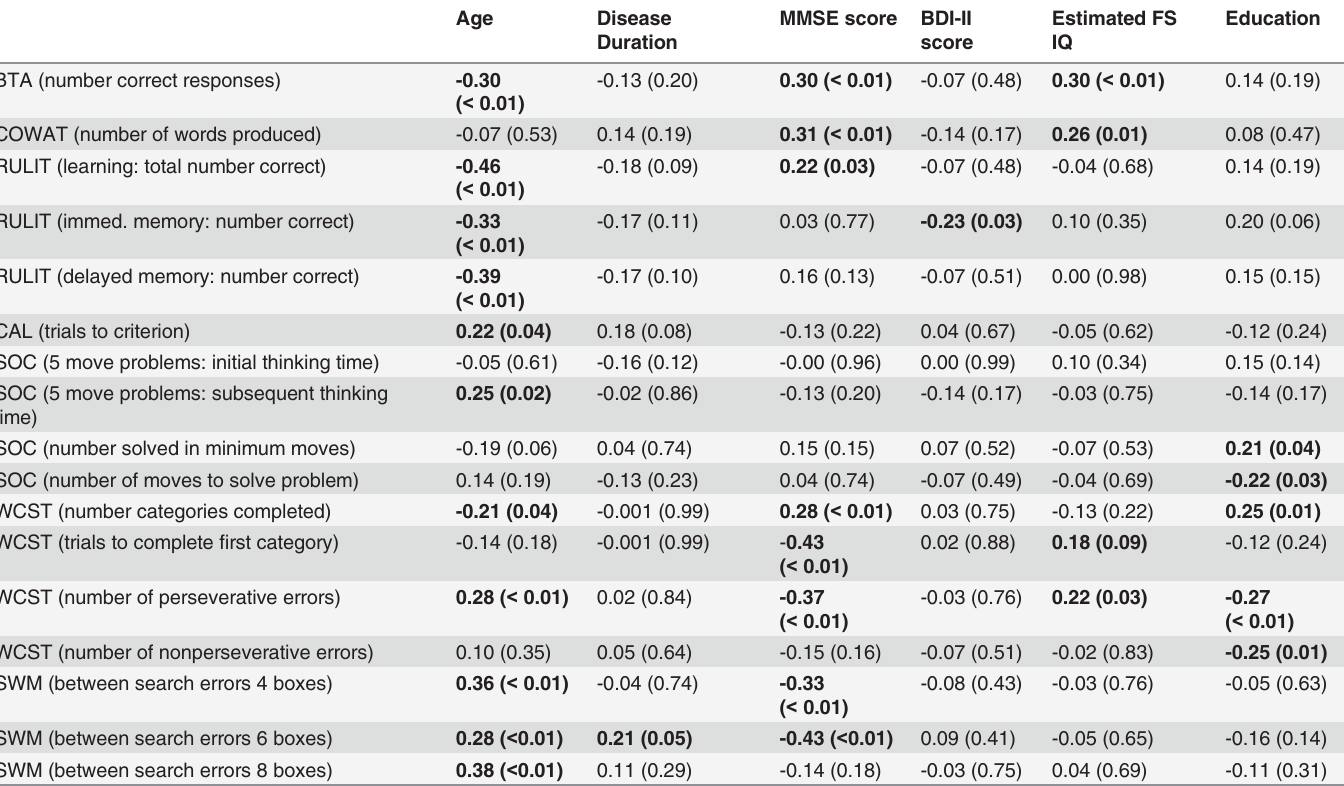
BDI-II score (Table 2). Relationships between performance on neuropsychological tests and demographic variables (Table 3) and performance on neuropsychological tests and UPDRS components (Table 4) Table 3. Correlations Between Neuropsychological Performance and Demographic Variables [r (p